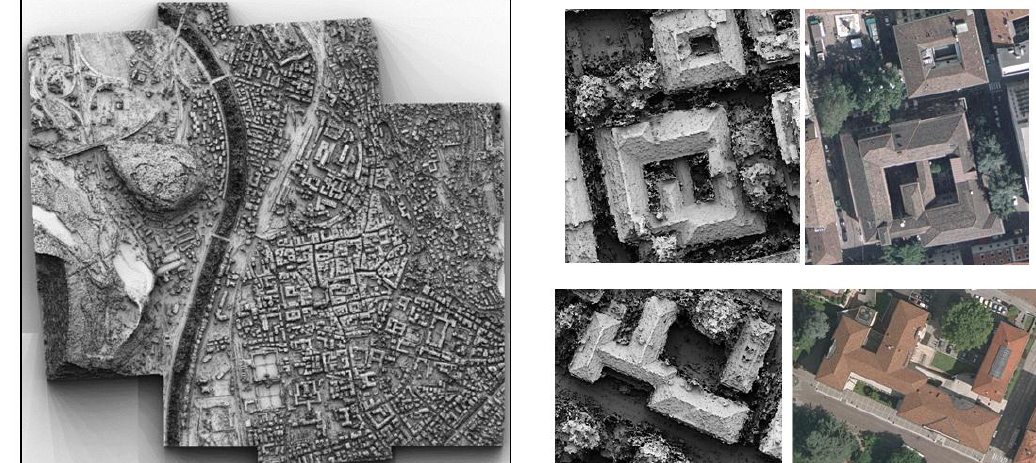
Figure 3: Shaded relief of the photogrammetric DSM (left). Details of the reconstructed roof geometries